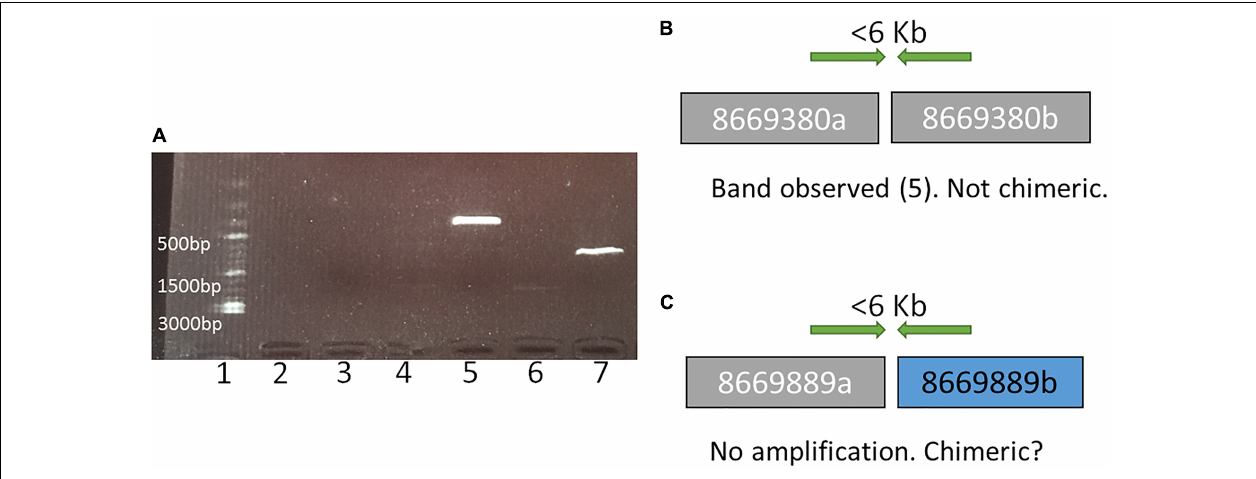
FIGURE 1 | An example of representation and interpretation of the results of polymerase chain reaction (PCR) run I. (A) an electrophoresis gel, where in well 1 is a DNA ladder, 2 is the control (no DNA), 3 and 4 exhibit no PCR amplification for tested SF adjacencies in scaffolds 8669889 and 8669009, respectively, broken by RACA; 5 and 7 show PCR amplification for tested SF adjacencies in scaffolds 8669380 and 8669417, respectively, broken by RACA; 6 shows PCR product of unexpected size (2000 bp) for scaffold 8667696. (B) A schematic representation and interpretation of the PCR results from well 5 (scaffold 8669380, SFs 8669380a and 8669380b); (C) A schematic representation and interpretation of the PCR results from well 3 (scaffold 8669889, SFs 8669889a, and 8669889b).